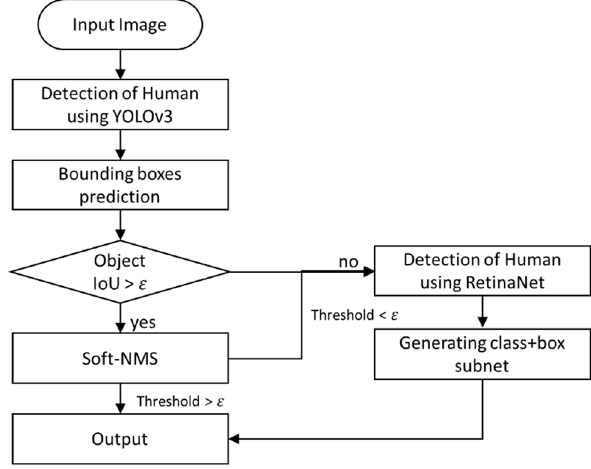
Figure 3. Hybrid Human Detection Flowchart.